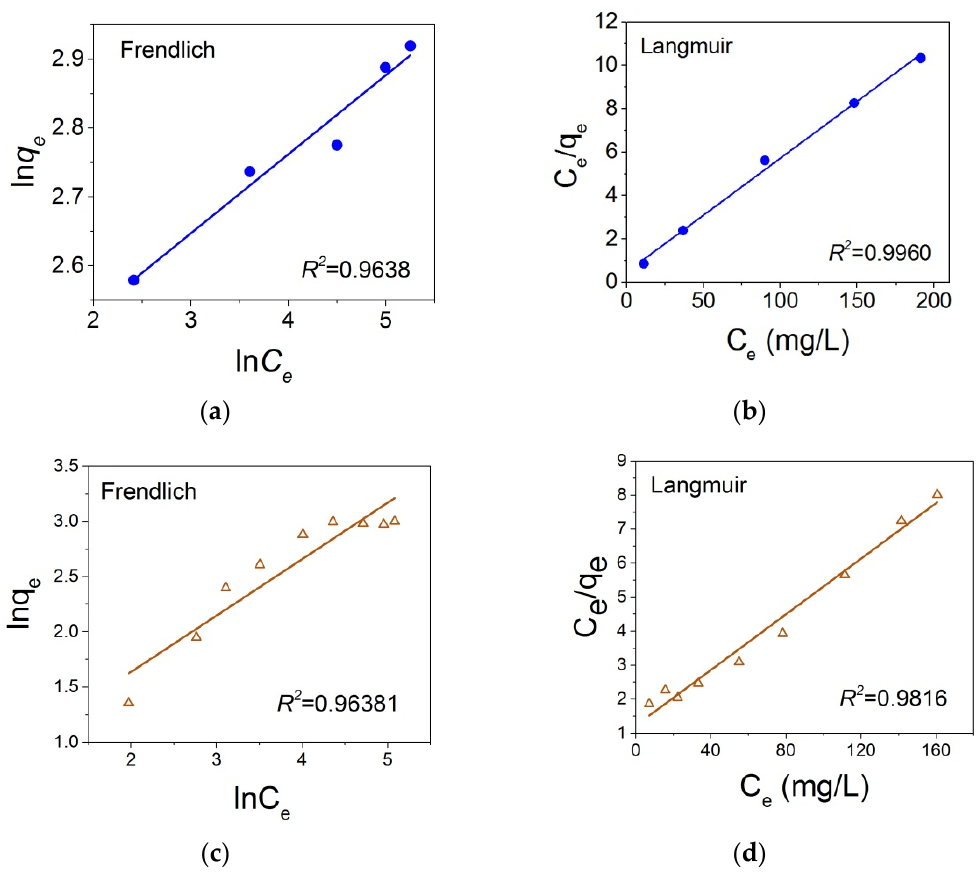
Figure 13. Adsorption Freundlich ( a , c ) and Langmuir ( b , d ) isotherms in the coordinates of their linear equations for MB ( a , b ) and for CR ( c , d ) on NPs Fe 3 O 4 @C. Recently, a combined adsorption isotherm, which integrates both Langmuir and Freundlich models described by the formulae, has become widespread.